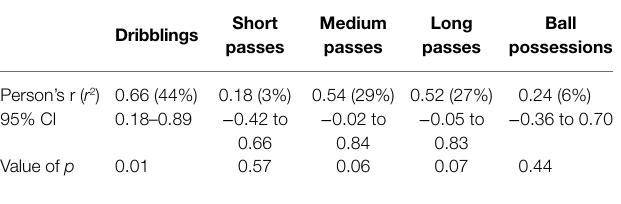
TABLE 1 | Pearson’s r ( r 2 ), 95% CI and values of p for correlations between the positional difference of the players in the study sample and the associated positional difference in the normative data for dribblings, short passes, medium passes, long passes, and ball